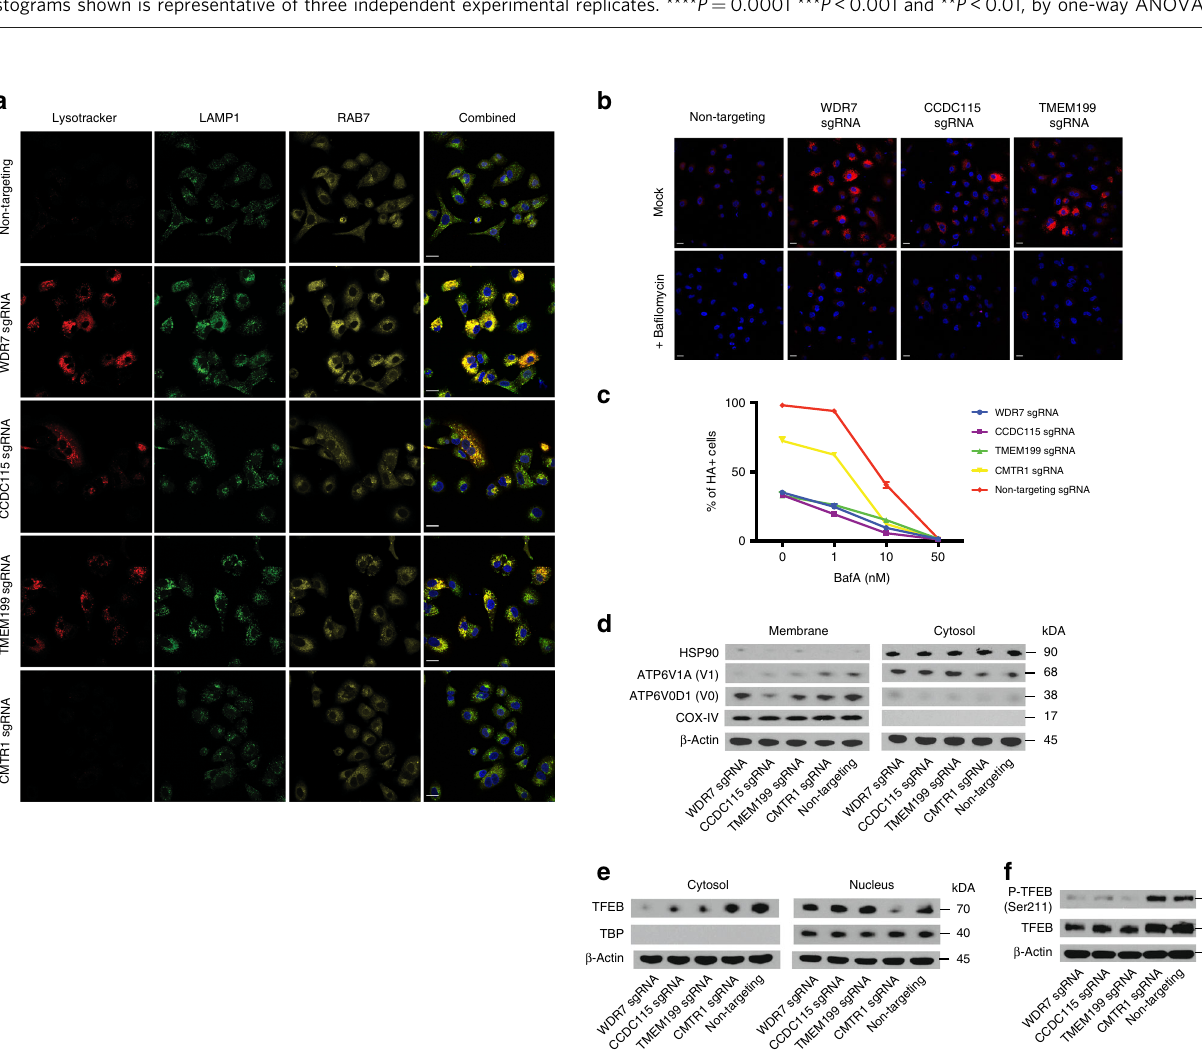
Fig. 5 WDR7, CCDC115 and TMEM199 regulate endo-lysosomal pH. a Immuno fl uorescence of A549 cells transduced with either gene-speci fi c or non- targeting sgRNA and stained with Lysotracker red, anti-LAMP1 and anti-Rab7 antibodies. Scale bar = 20 μ m. b Lysotracker red staining of A549 cells transduced with either gene-speci fi c or non-targeting sgRNA. Cells were mock-treated or treated with 100 nM Ba fi lomycin A (BafA). Scale bar = 20 μ m. c A549 cells transduced with either gene-speci fi c or non-targeting sgRNA were treated with different concentrations of BafA followed by PR8 virus infection. Error bars represent standard deviations from two independent experimental replicates. d A549 cells transduced with either gene-speci fi c or non-targeting sgRNA were fractioned into membrane and cytosolic components. The two fractions were then subjected to SDS-PAGE and Western blotting using antibodies against subunit A of the V 1 domain and subunit D of the V 0 domain as measure of V-ATPase assembly. Western blotting was also performed for HSP90 (cytosolic) and COX-IV (membrane) as positive controls. e Cytosolic and nuclear proteins were extracted from A549 cells transduced with either gene-speci fi c or non-targeting sgRNA using the NE-PER Nuclear and Cytoplasmic extraction kit. Samples in each fraction were subjected to SDS-PAGE and western blotting using antibodies against TFEB. Western blotting for TATA-binding protein (TBP) was used as positive control. f Whole cell lysates were extracted from A549 cells transduced with either gene-speci fi c or non-targeting sgRNA. Samples were subjected to SDS-PAGE and western blotting using antibodies against TFEB and Phospho-TFEB